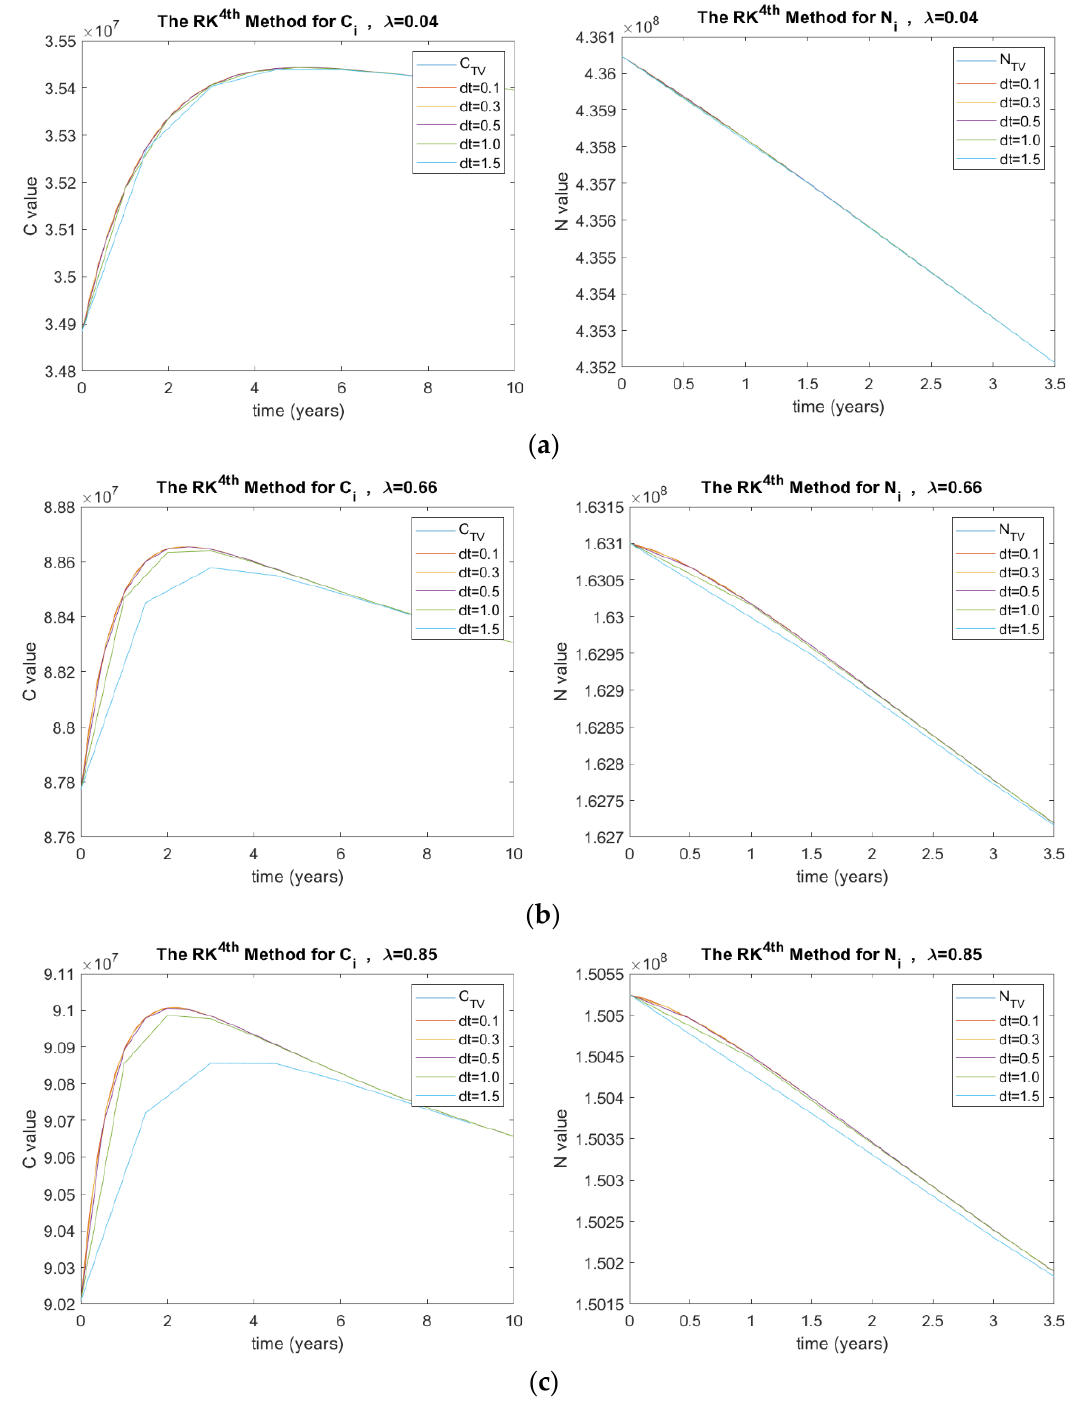
Figure 4. ( a ) Stability analysis for RK method when λ = 0.04 , ( b ) λ = 0.66 , and ( c ) λ = 0.85 . Where C is the number of diabetic patients with complications and C TV is its true value, N is the total number of people with diabetes and N TV is its true value, and d t is the time step The Mortality Rate Due to Complications ( 𝛿 ) The investigated 𝛿 values in this paper are 0.02, 0.05, 0.1, and 0.35. Figure 5 shows the results of C i and N i for the RK method in terms of 𝛿 and ∆𝑡 , where (a) 𝛿 = 0.02 , (b) 𝛿 = 0.05 , (c) 𝛿 = 0.1 , and (d) 𝛿 = 0.35 .